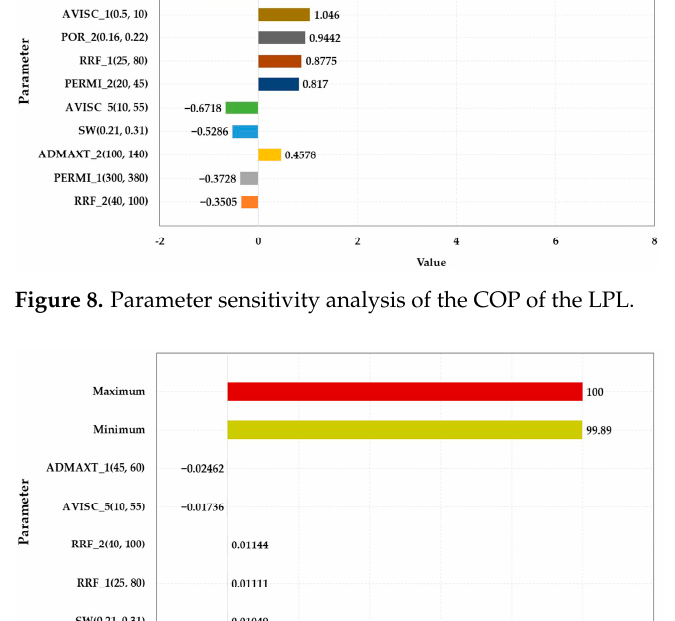
Figure 10. Parameter sensitivity analysis of the water cut of the LPL. 3.2.3. History Matching of the Gel Flooding Experiment According to the sensitivity analysis results of the characteristic parameters, the in- fluence of each parameter on the two important production parameters, the COP and the water cut of gel flooding, was clarified. Therefore, the history matching of the gel flooding experiment was effectively accelerated by modifying the main influencing parameters within a reasonable adjustment range for the production parameters that were not ideal, and good history matching was achieved, as shown in Figure 11. Figure 11. History matching results of the gel flooding experiment. 3.2.4. Model and History Matching of the Conglomerate Reservoir in the Xinjiang A Oil- field The grid number of the model of the conglomerate reservoir in the Xinjiang A Oilfield is 87 × 65 × 35 = 197,925. The distribution of permeability, initial pressure, porosity, and initial oil saturation is shown in Figure 12.